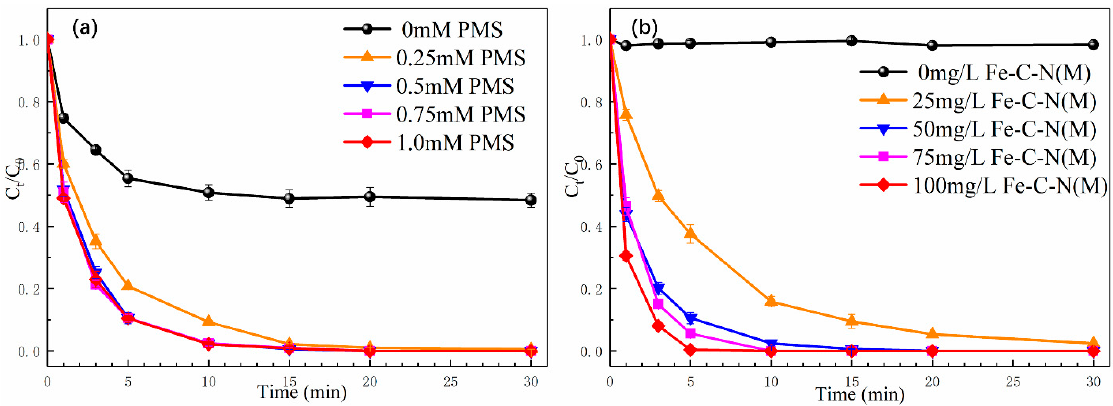
Figure 7. ( a ) Effect of PMS dosage; ( b ) Effect of catalyst dosage.